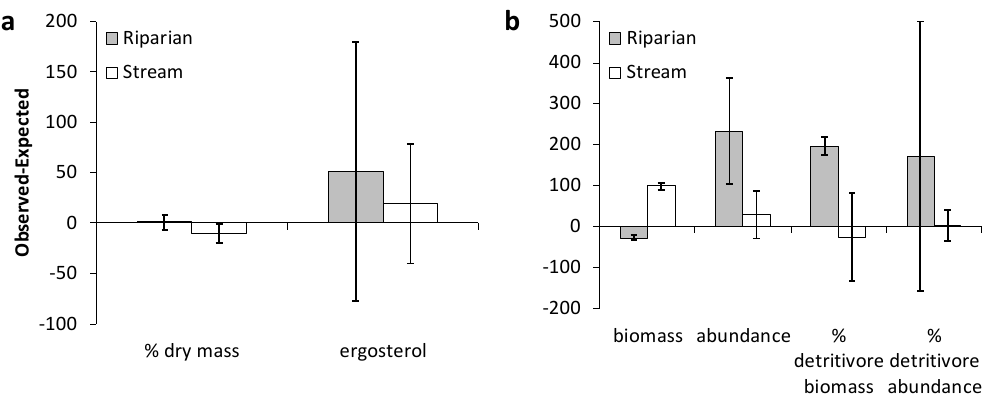
Figure 4. Difference between observed (mixture) and expected (average of single-species) values of (a) dry mass and ergosterol concentrations, and (b) invertebrate colonisation, calculated as 100 × ((observed − expected)/expected). Values are means of all samples ± 95% confidence intervals ( n = 6). Mixtures are considered non-additive for a given variable when the CI bar does not cross the y = 0 line.